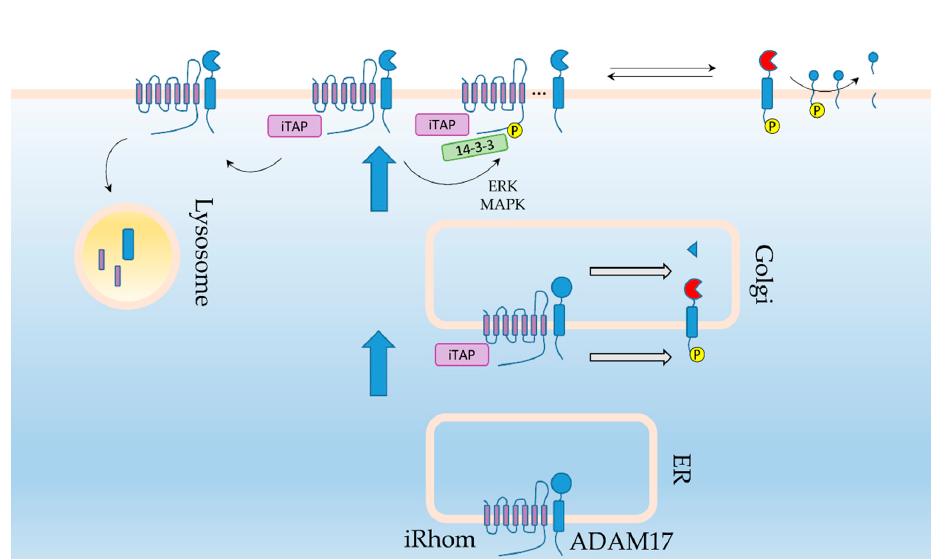
Figure 2. iRhom regulation of ADAM17. iRhom binds to ADAM17 in the ER facilitating its export to the Golgi where it can begin its posttranslational modification fueled activation. iRhom and ADAM17 continue to the cell surface where in the presence of iTAP the complex is stabilized. In its absence the complex is sent for endocytosis and lysosomal degradation. Phosphorylation of iRhom by ERK and MAPK allows iRhom to bind to 14-3-3 proteins, which in turn facilitate release of ADAM17 from the complex to allow final activation and shedding of its